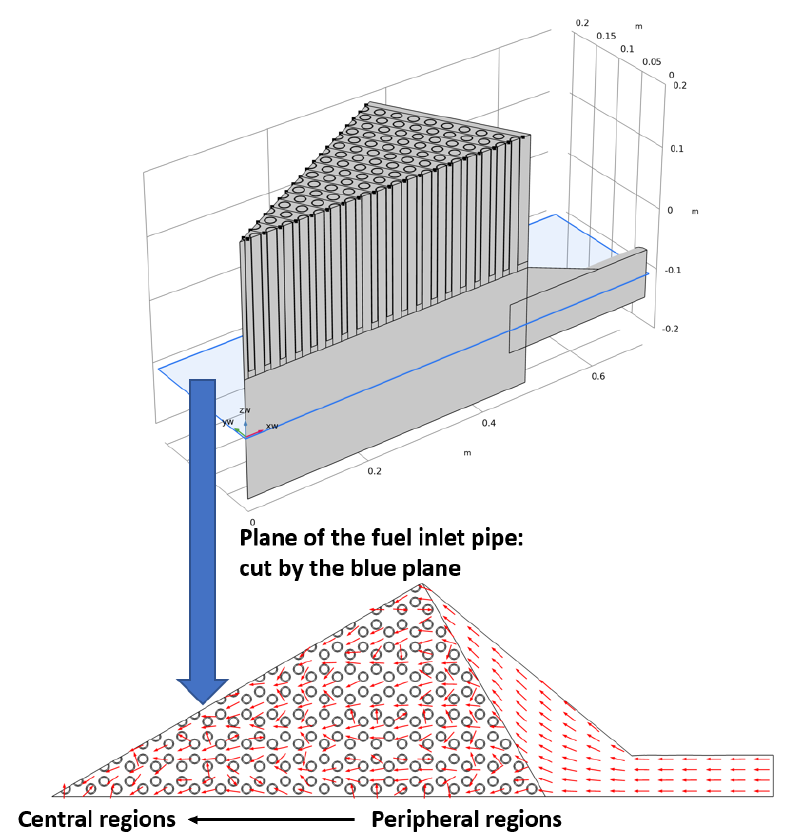
Figure 11. Top, plane of the fuel inlet pipe cut by the blue plane; bottom, Velocity vector field on the plane of the fuel inlet pipe of the molten salt.